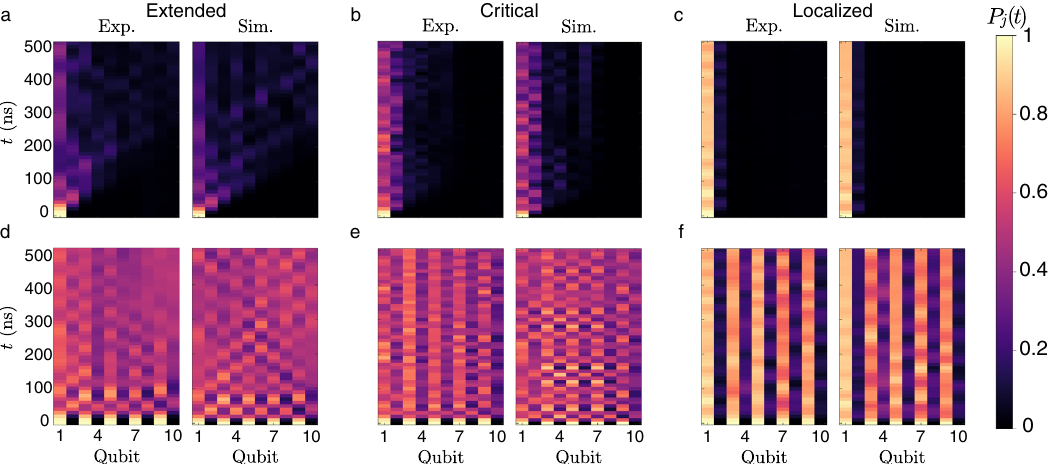
Fig. 2 Spin transport. The time evolutions of qubit-resolved on-site population P j ( t ) for the system initialized in ( a – c ) ψ ð 0 Þj i ¼ 1000000000 j i , and ( d – f ) ψ ð 0 Þj i ¼ 1010101010 j i , in ( a, d ) the extended phases with μ = 0.5 and V = 0.5; b, e the critical phases with μ = 2.0 and V = 0.5; c, f the localized phases with μ = 0.5 and V = 4.0. The left panel of each fi gure shows experimental data, and the right panel shows numerical simulation. Experimental data are averaged over 5 different choices of δ , while numerical results are averaged over 50 choices of δ with decoherence taken into